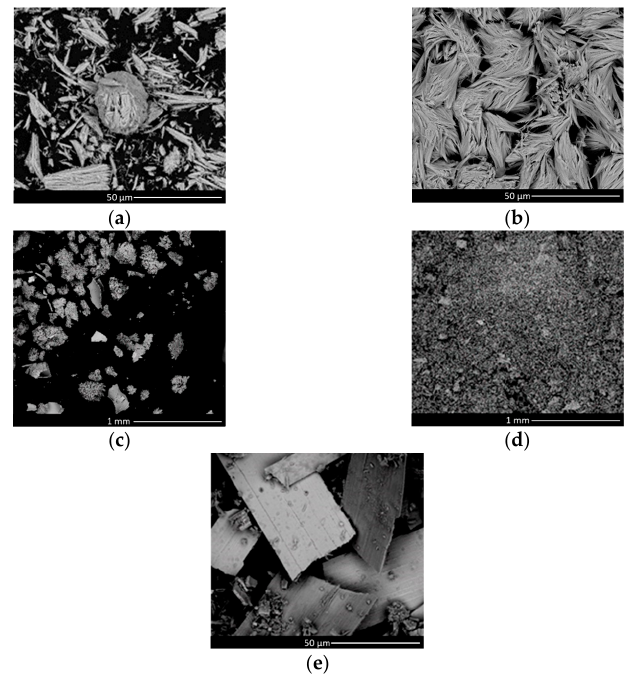
Figure 4. SEM image of samples taken from SPIDER: ( a ) Sample PDP_4, ( b ) Sample PDP_6, ( c ) Sample BP_9 (bottom left) ( d ) Sample BP_10 (bottom right), ( e ) Sample PG_11 (beamlets apertures).